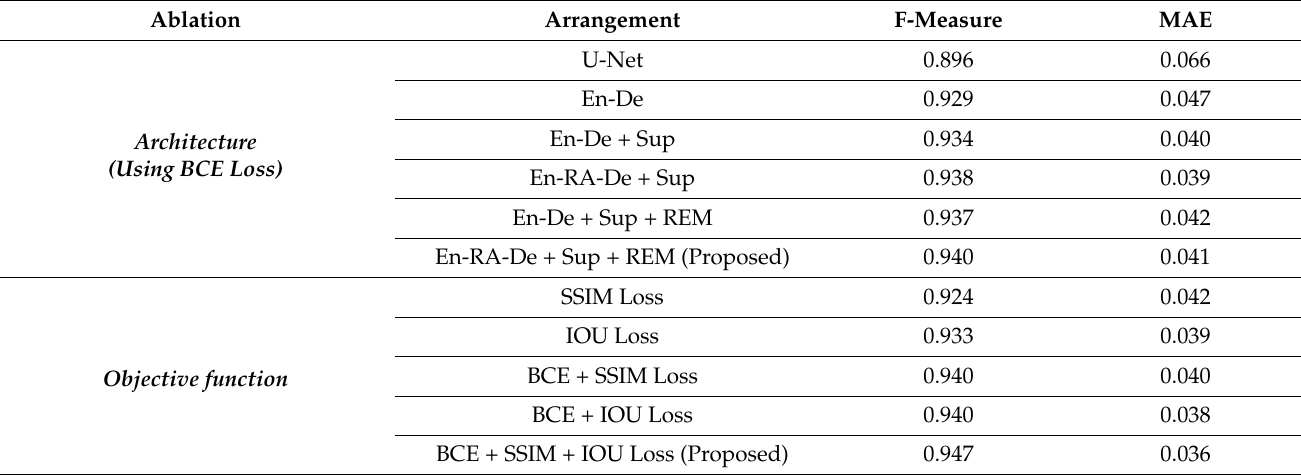
Table 2. Ablation studies conducted by taking various combination of modules and losses to investigate the utility of each component of the proposed Revise-Net model. Ablation Arrangement F-Measure